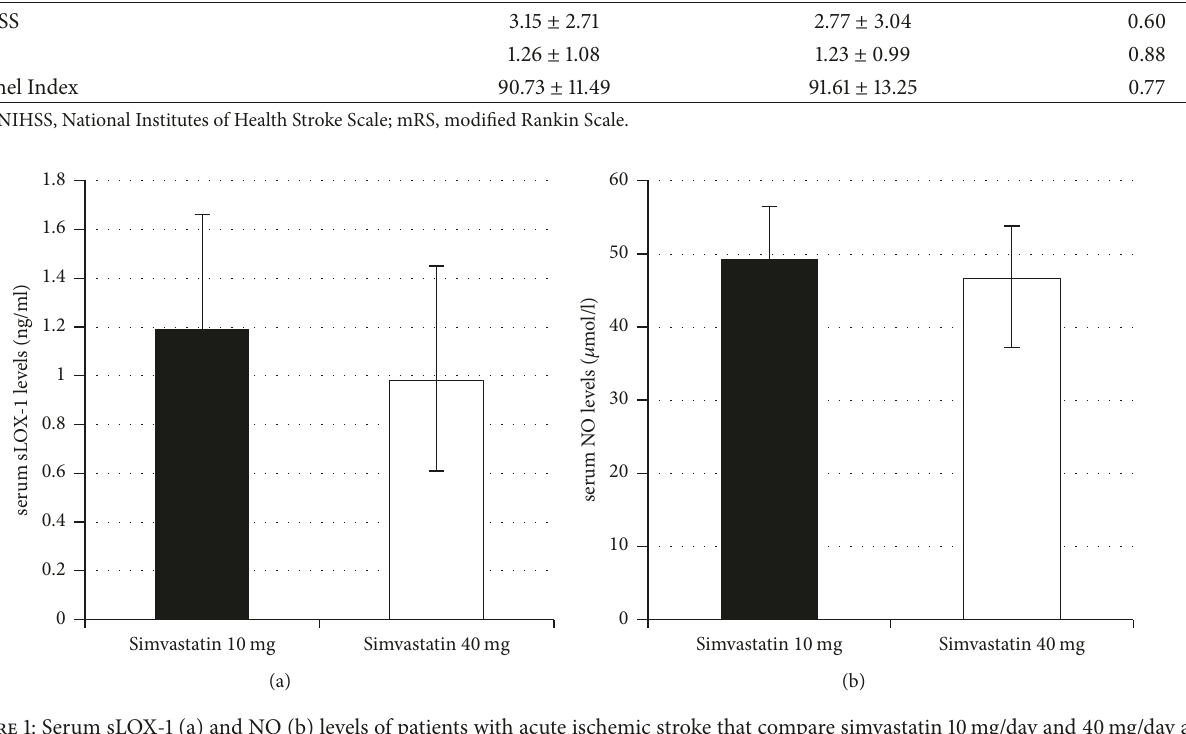
Table 6: Compare neurological outcome in patient with acute ischemic stroke at 90 days after simvastatin therapy. Parameter